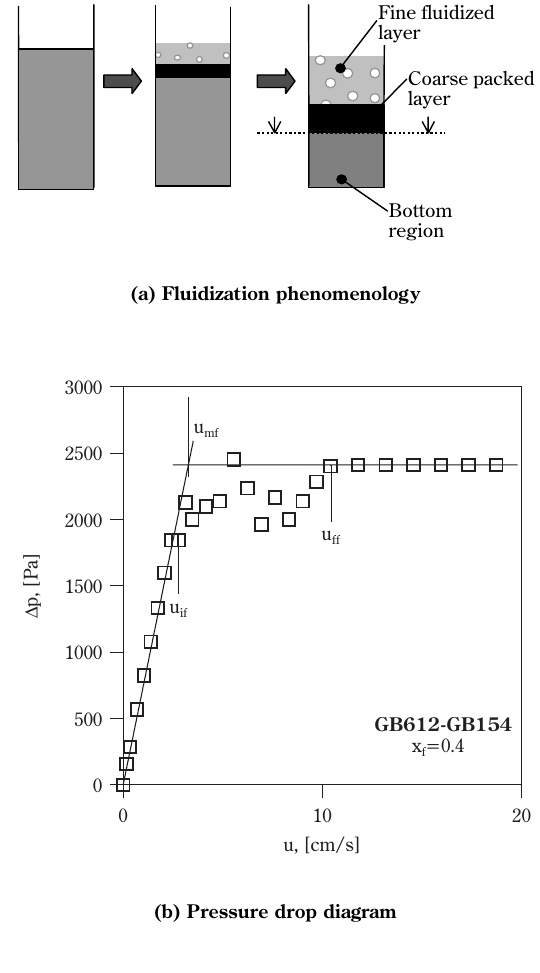
Fig. 2 Fluidization of a two-component